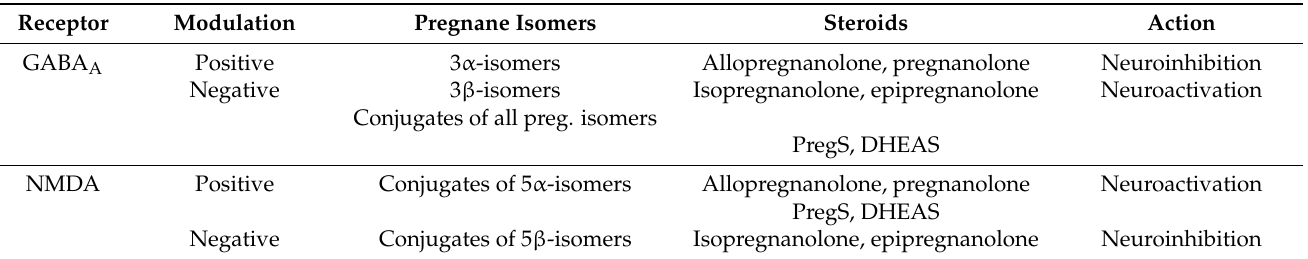
Table 3. Neuroactive metabolites of progesterone and their action. DHEAS — dehydroepiandrosterone sulfate; PregS — pregnenolone